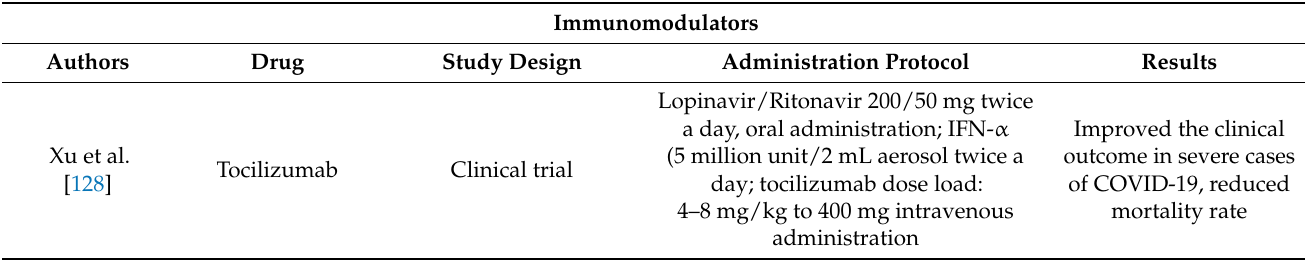
Table 5. Summary of the in vivo studies included about immunomodulator treatments for viral